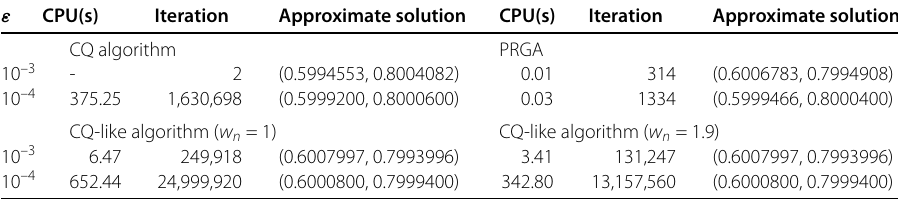
Table 1 Numerical results for Example 5.1 ( x 1 = (10,10) T , ρ n = ρ = 0.06 for all n ∈ N